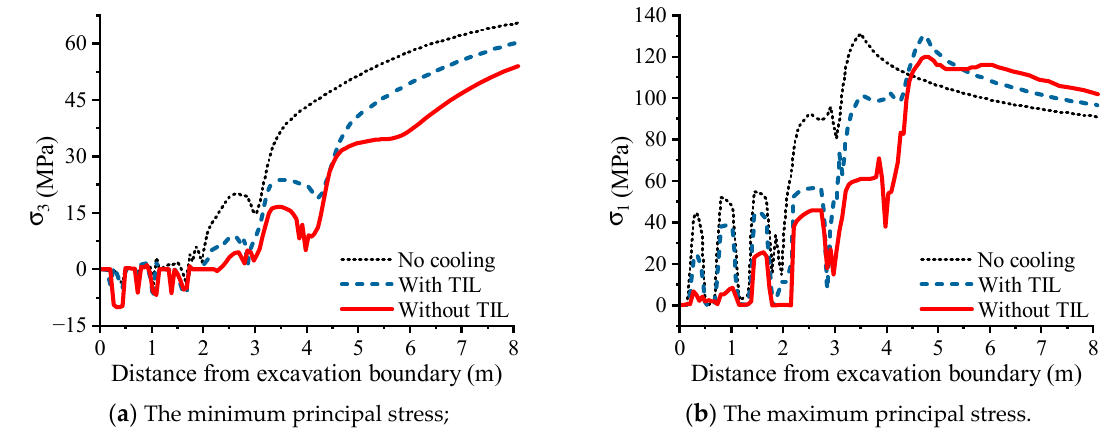
Figure 15. Stress state along the cross radial horizon of circular tunnel in the end of ventilation cooling. Figure 16 shows the scales of EDZs and their evolution process along with ventilation time. With the ventilation time passing by, EDZ d , HDZ d , EDZ a and HDZ a gradually grew. Finally cooling as well had a significant impact on the development of fracture zones in surrounding rock. Having undergone ventilation cooling for 14 days with and without TIL, the breadth of EDZ d increased by 0.87 m and 1.87 m, and the coverage of EDZ a in- creased by 27.7 m 2 and 58.28 m 2 , respectively. The expansion of EDZ scales with cooling time experienced three stages: (1) Slow expansion stage: in the very beginning, i.e., the